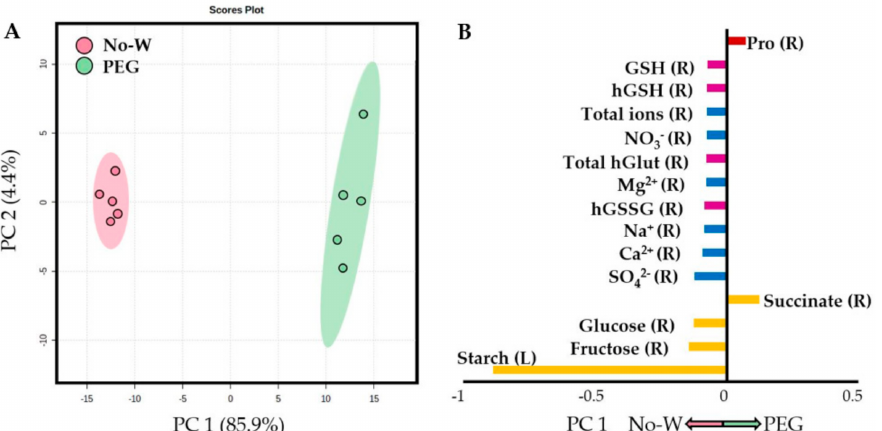
Figure 2. Principal Component Analysis (PCA) conducted with all measured parameters in No-W and PEG-6000 treated plants. ( A ) PCA scores plot showing the non-irrigated (No-W) and PEG- 6000 cases. ( B ) Loading values of all variables in PC1 separating both treatments. GSH, reduced glutathione; hGlut, homoglutathione; hGSH, reduced homoglutathione; hGSSG, oxidized homoglu- tathione; L, leaves; R, roots. Bar key: yellow, carbohydrates; blue, inorganic ions; pink, antioxidants; red, amino acids.